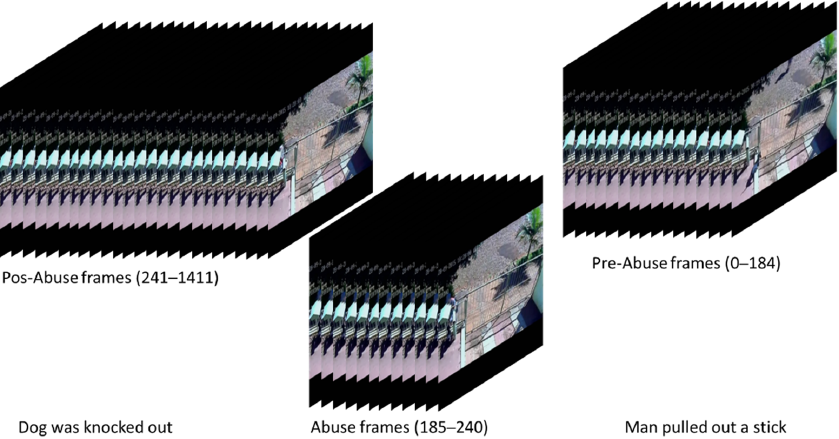
Figure 1. An example of a weakly surprised anomaly video in the UCF-Crime dataset [5] under the subcategory of abuse (Abuse028_x264.mp4). (The video contains 1412 frames, where the abuse scene lasted around 56 frames corresponding to approximately 4% of the total frames).